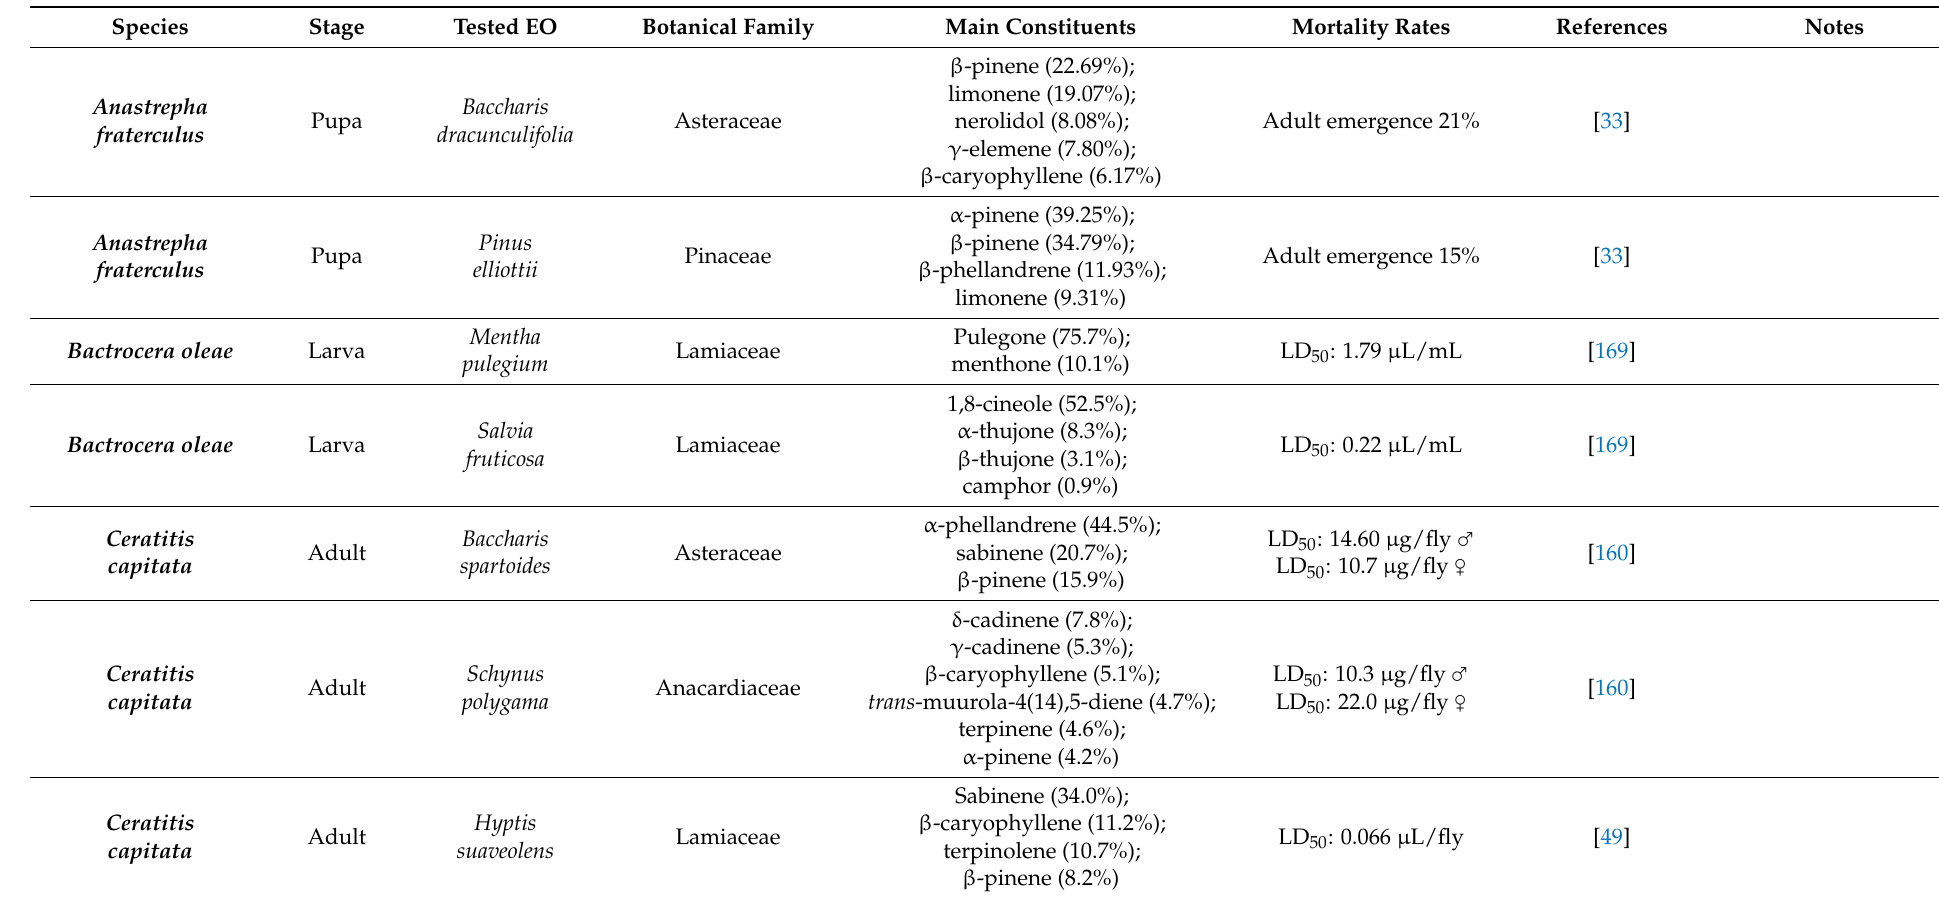
Table 4. Essential oils (EOs) were examined for topical/contact action against immature and adult stages of Tephritidae flies. In addition to mortality, the percentage of main compounds of tested EOs is